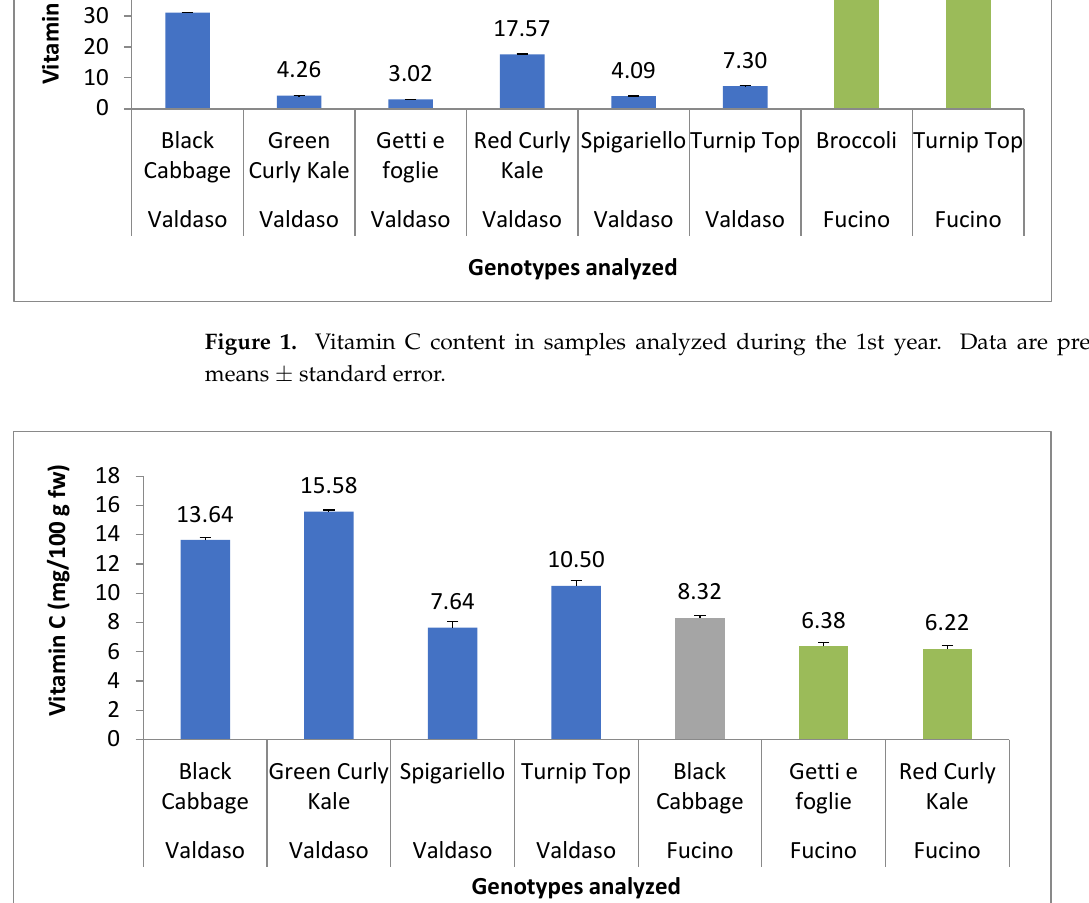
Figure 2. Vitamin C content in samples analyzed during the 2nd year. Data are presented as means ± standard error.